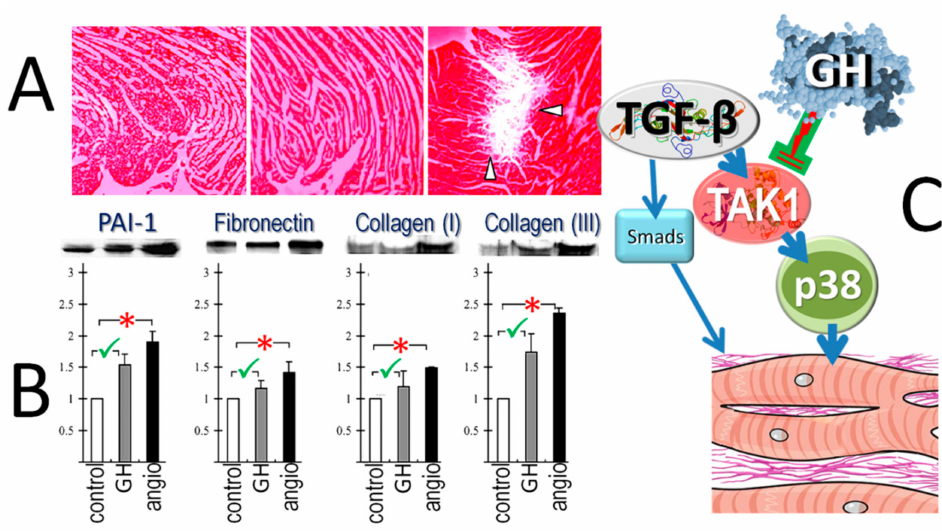
Figure 8. Growth hormone (GH) prevents fibrosis in the non-infarcted myocardium. GH inhibits transforming growth factor- β (TGF- β ) signaling via TGF- β -activated kinase 1 (TAK1), leading to de-phosphorylation of p38 MAPK. As a result, the extracellular matrix is preserved, as shown by the absence of metalloproteinase activity (in situ zymography, ( A ). Furthermore, the expression of proteins related to TGF- β , such as plasminogen activator inhibitor-1 (PAI-1), fibronectin, collagen-I and collagen-III is reduced ( B ), and fibrosis is prevented in the remote myocardium ( C ). These e ff ects contrast the fibrogenic e ff ects of angiotensin-II (angio), pointed by arrows in ( A ) and by asterisks in ( B ). From Imanishi et al., Mol Cell Endocrinol (2004), 218, 137–146 [58], with